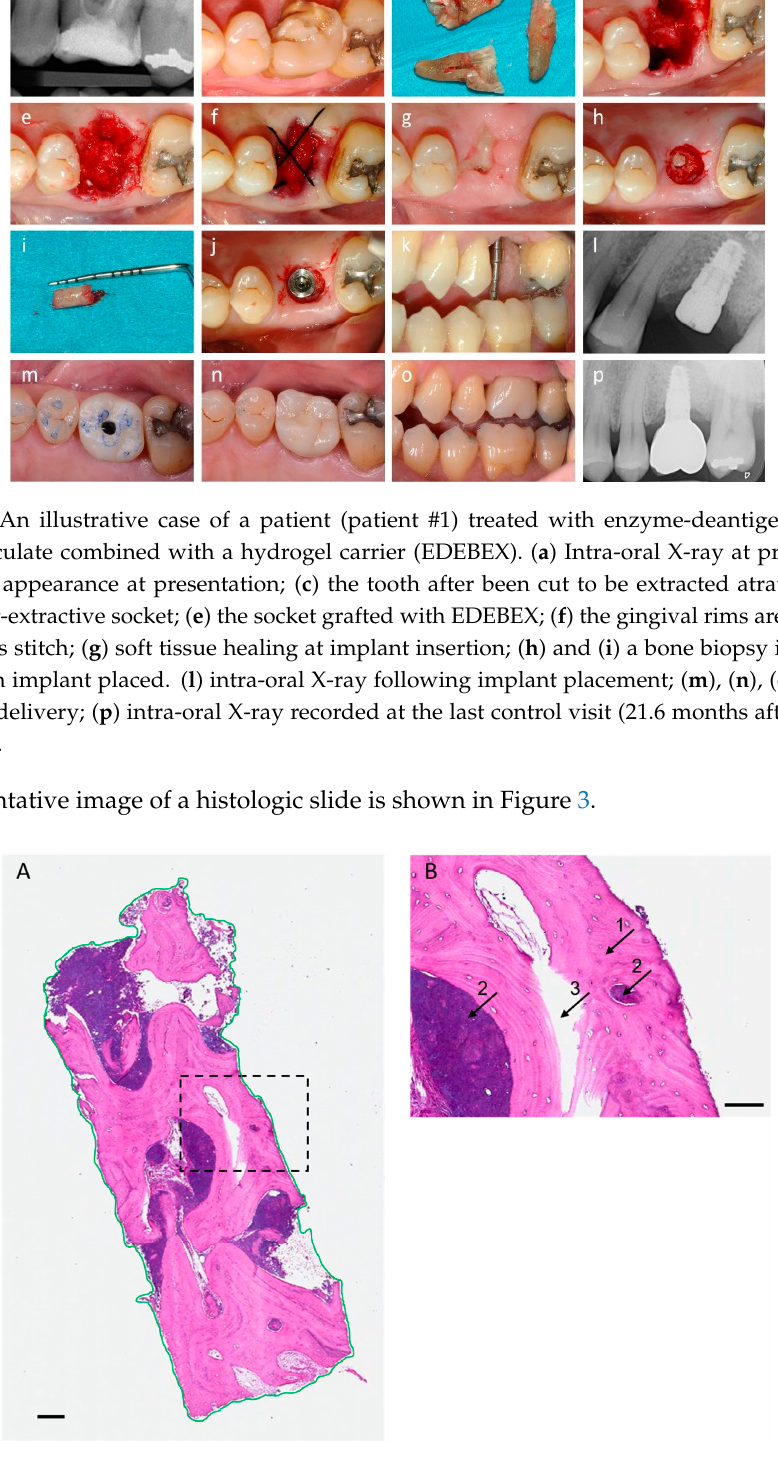
Table 2. Outcome at final follow-up according to the Albrektsson and Zarb [25] criteria. In particular, these criteria were: (1) absence of persistent pain, dysesthesia, or paresthesia in the implant area; (2)